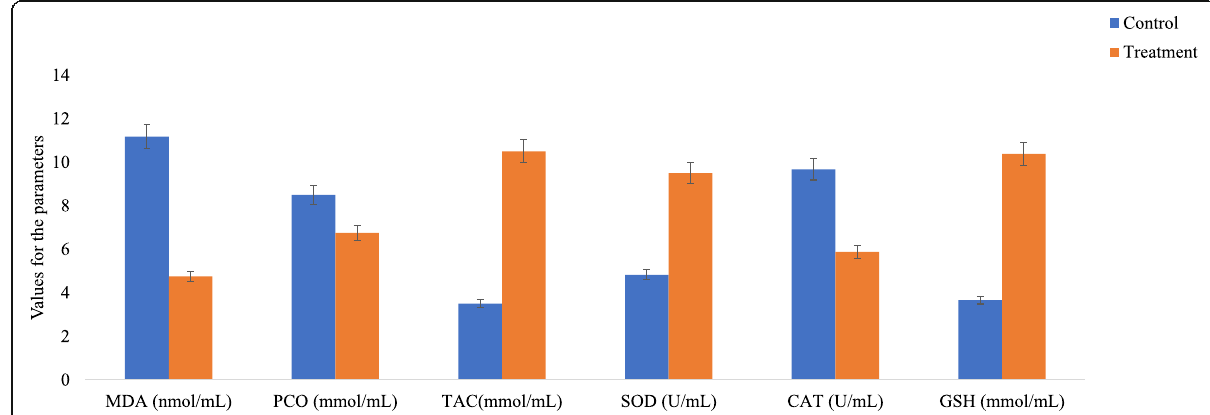
Fig. 2 Comparative concentration of oxidative stress biomarkers in the serum of the rabbits. The biomarkers determined in the serum were malondialdehyde (MDA), protein carbonyl (PCO), total antioxidant capacity (TAC), superoxide dismutase enzymes (SOD), catalase (CAT) activities, and glutathione concentration (GSH) which were used as measurement for determining the oxidative stress status of the rabbits. Control group